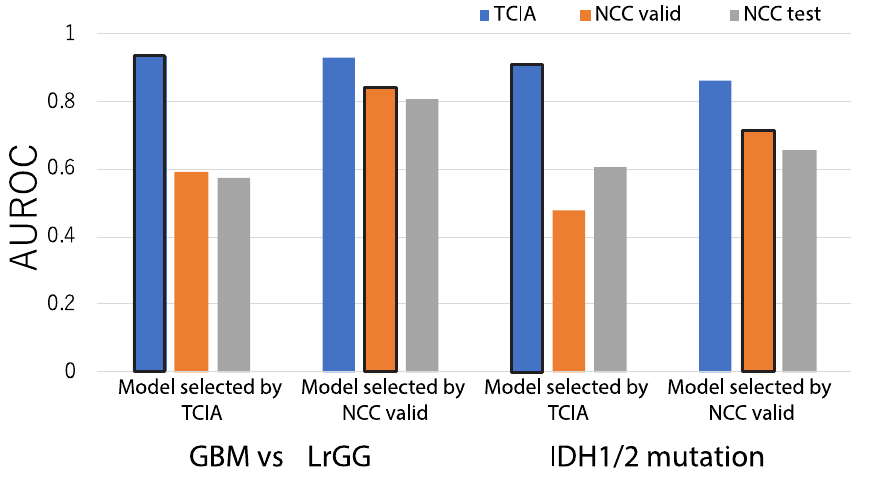
Figure 5. Comparison of classification performances between the highest accuracy model in the TCIA and NCC validation dataset. The leftmost chart shows accuracies yielded by the model that showed the highest accuracy under cross validation within TCIA. The second leftmost chart shows the accuracies yielded by the model that showed the highest accuracy via the NCC validation set. The two graphs on the right depict the same settings as the previous examples, except that the prediction target is IDH mutation prediction.